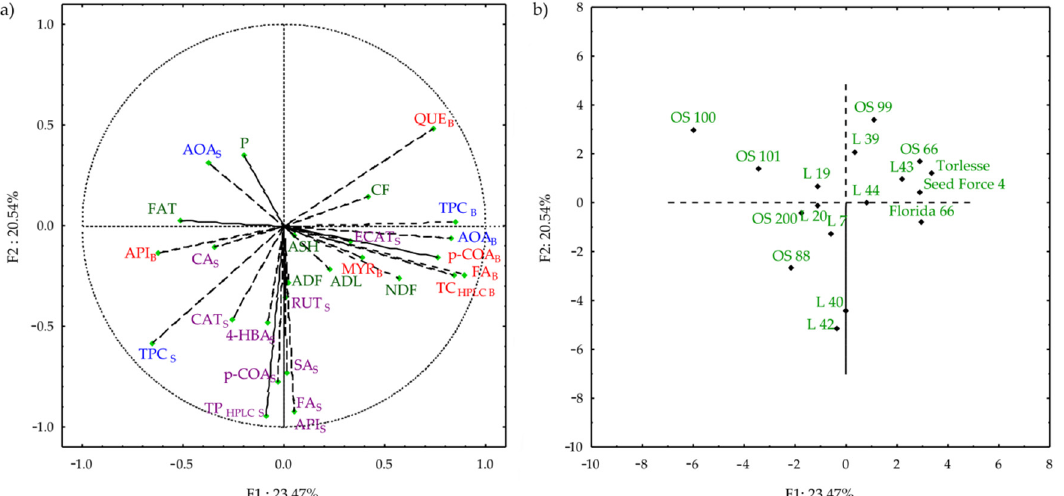
Figure 4. Biplot relative to the principal component analysis (factor loadings ( a ) and scores ( b ) of first two factors) performed on the nutritive and data on phenolics (CP—crude protein; FAT—crude